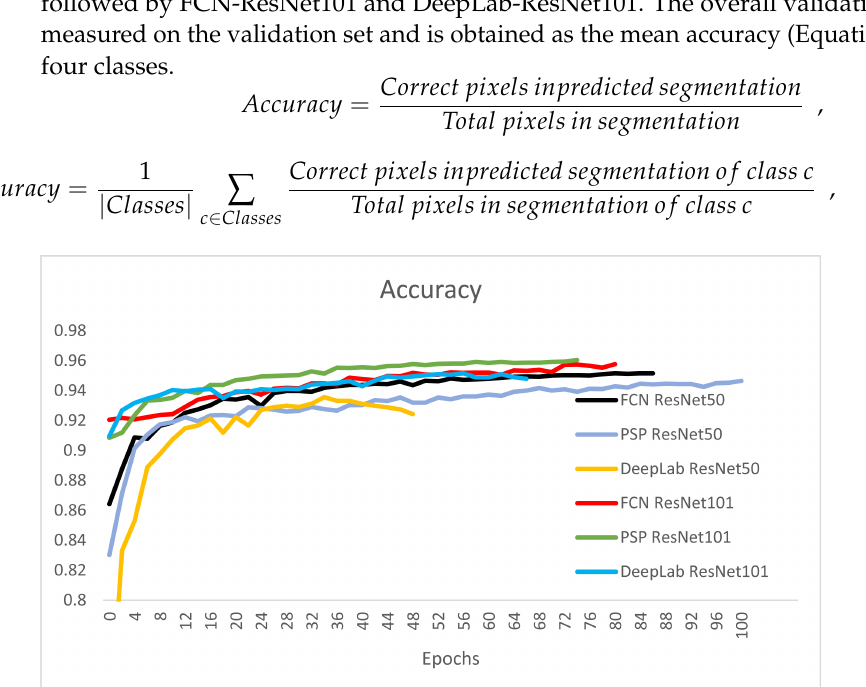
Figure 9. Validation Accuracy: the best architectures based on the validation accuracy are: PSP- ResNet101 (accuracy of 0.9604), DeepLab-ResNet101 (accuracy of 0.9479), FCN-ResNet101 (accuracy of 0.9576), and FCN-ResNet50 (accuracy of